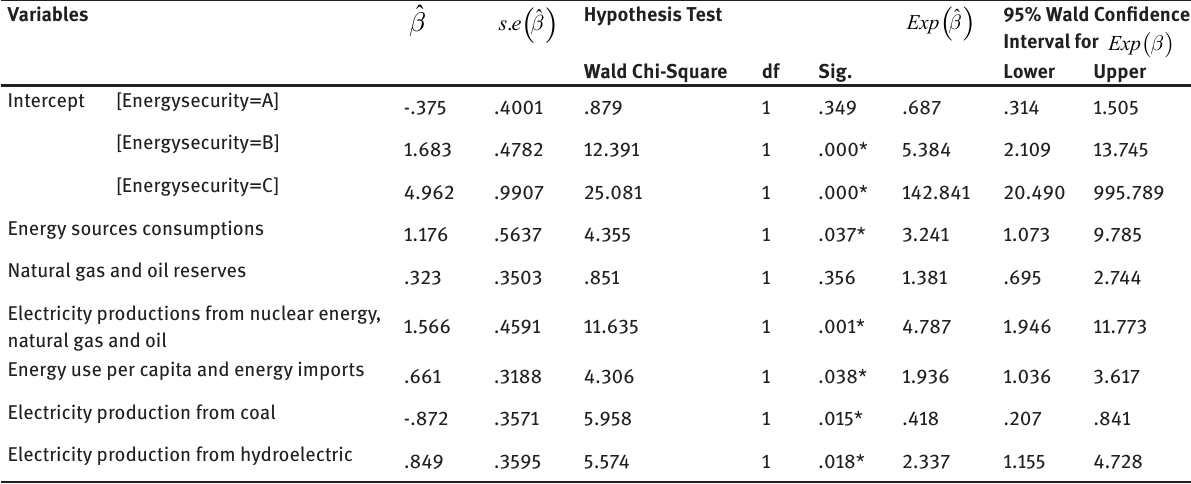
Table 6: Results for GLM by using ML method with hybrid iterative algorithm under cumulative logit link function. Variables